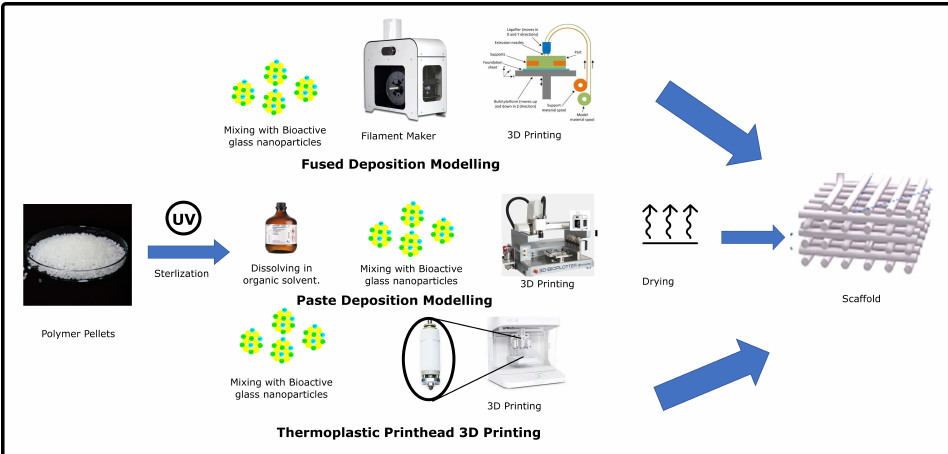
Figure 4. Workflow for different strategies for extrusion-based 3D printing of thermoplastic polymers- bioactive glass scaffolds. (Reproduced with permission from [61] under creative commons CC-BY license) (Reproduced with permission from [73] Copyright 2014,